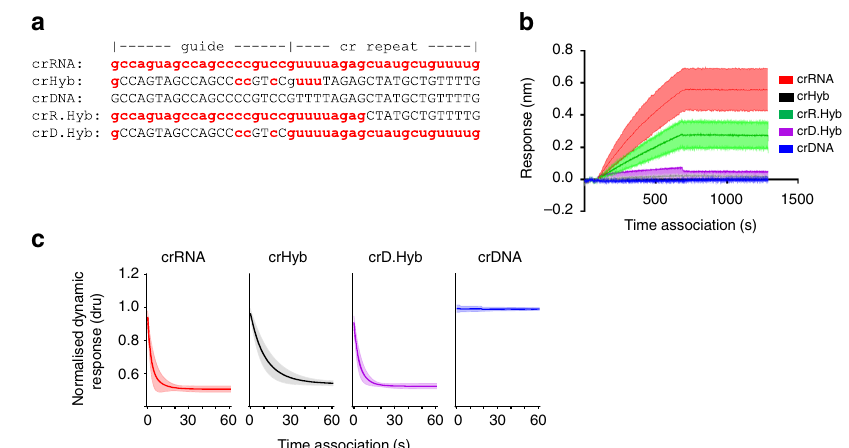
Fig. 3 DNA in the crXNA molecule affects target-binding af fi nities. a Nucleoside composition of AAVS1 crXNA molecules; RNA shown in lowercase red, DNA in uppercase black. b BLI sensogram showing association kinetics to immobilised AAVS1 target DNA of Cas9:tracrRNA complexed with crRNA (red), crHyb (black), crDNA (blue), crR.Hyb (green) or crD.Hyb (purple). Shaded areas show SD of three independent measurements. c SwitchSENSE sensogram showing association phase of Cas9:tracrRNA:crXNA complexes binding to target DNA. Shaded areas show SD of four independent